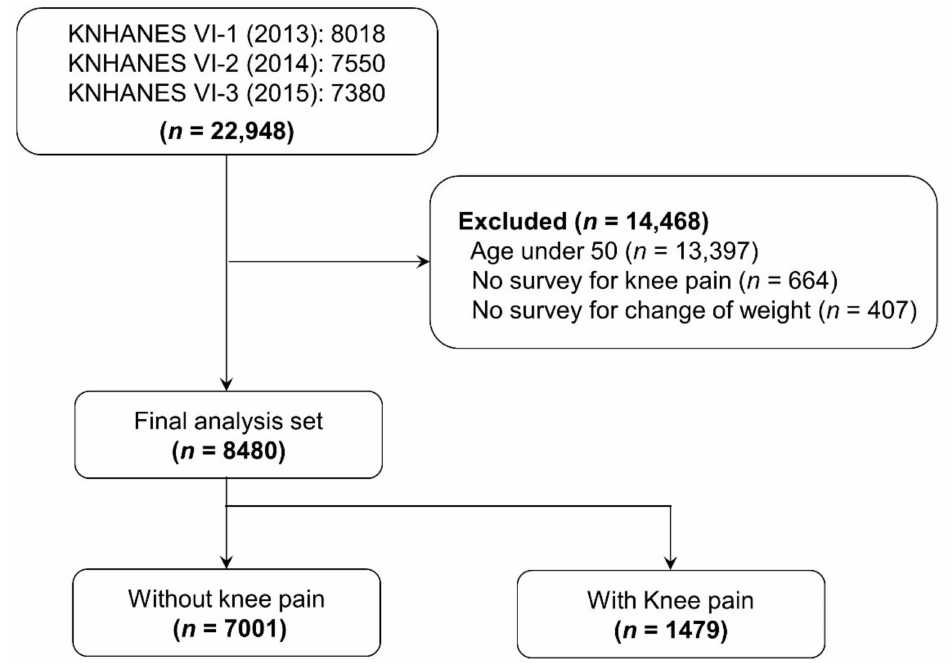
Figure 1. Flow chart of the study populations of the 2013–2015 Korea National Health and Nutrition Examination Surveys (KNHANES VI-1-3,